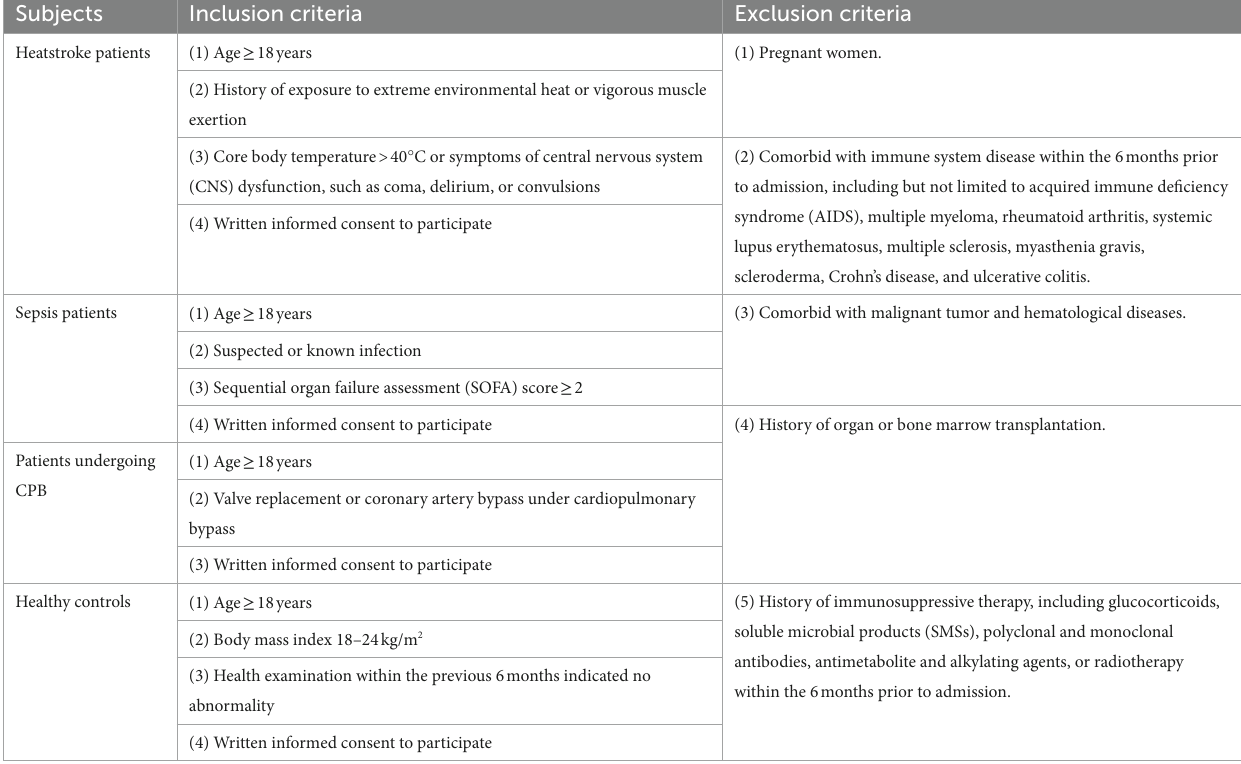
TABLE 1 Inclusion and exclusion criteria for subject